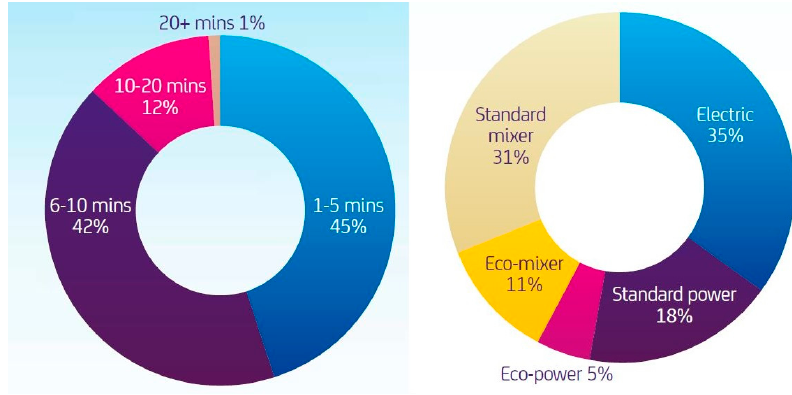
Figure 8. Distribution of showering times and shower types [13].